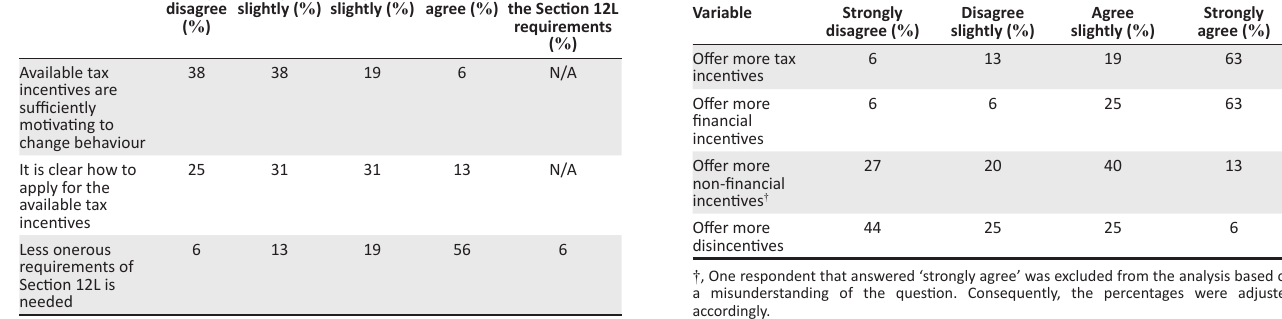
TABLE 8: Preference of government measures to encourage energy efficiency or renewable energy in South Africa.